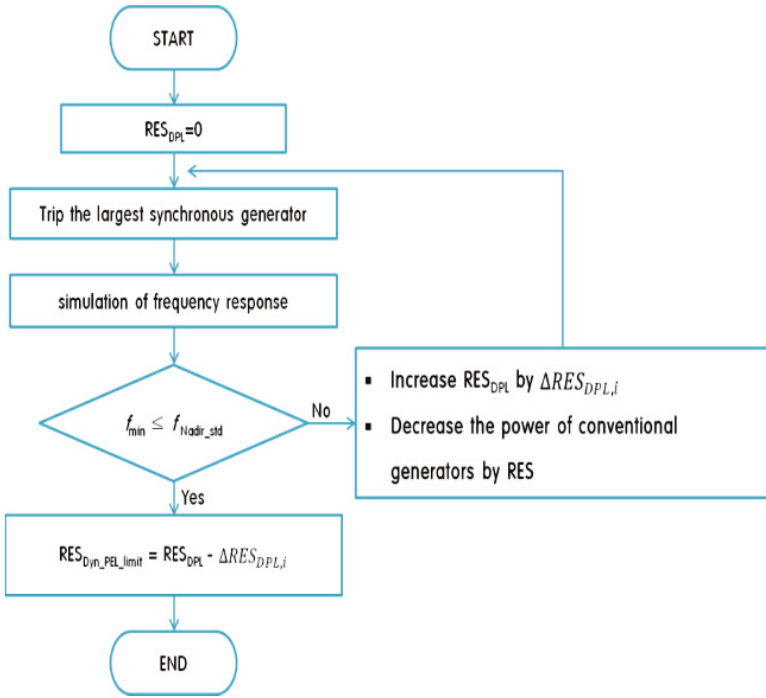
Figure 4. Evaluation procedure for the dynamic penetration limit of RES.